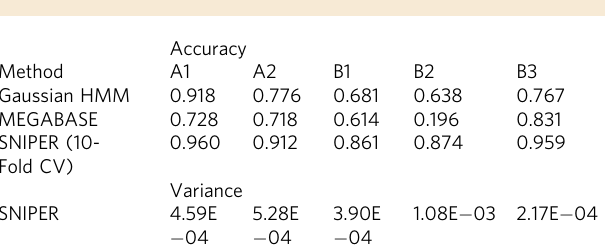
Table 1 Accuracy of predicting GM12878 annotations for 100 kb bins using the baseline Gaussian HMM, MEGABASE 17 , and SNIPER (average across 10-fold cross validation)